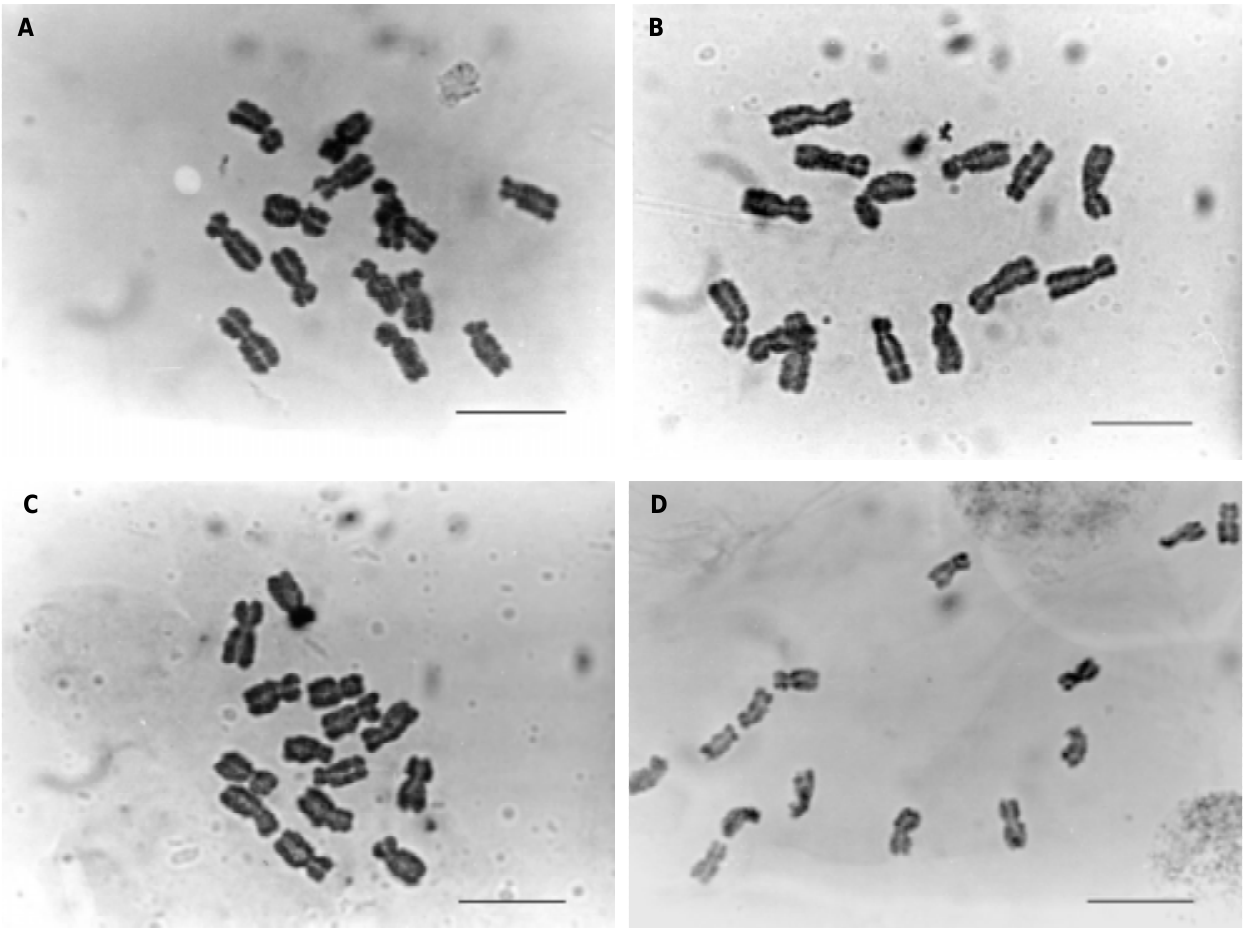
Figure 1 - Metaphase plates of Lathyrus nervosus (A), L. pubescens (B), L. paranensis (C) and L. crassipes (D). Scale: 10 m